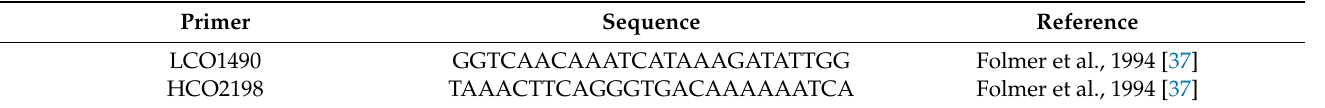
Table 2. PCR primers used to sequence mt COI genes of Limnephilus deqianensis n. sp. in this study. Primer Sequence Reference LCO1490 GGTCAACAAATCATAAAGATATTGG